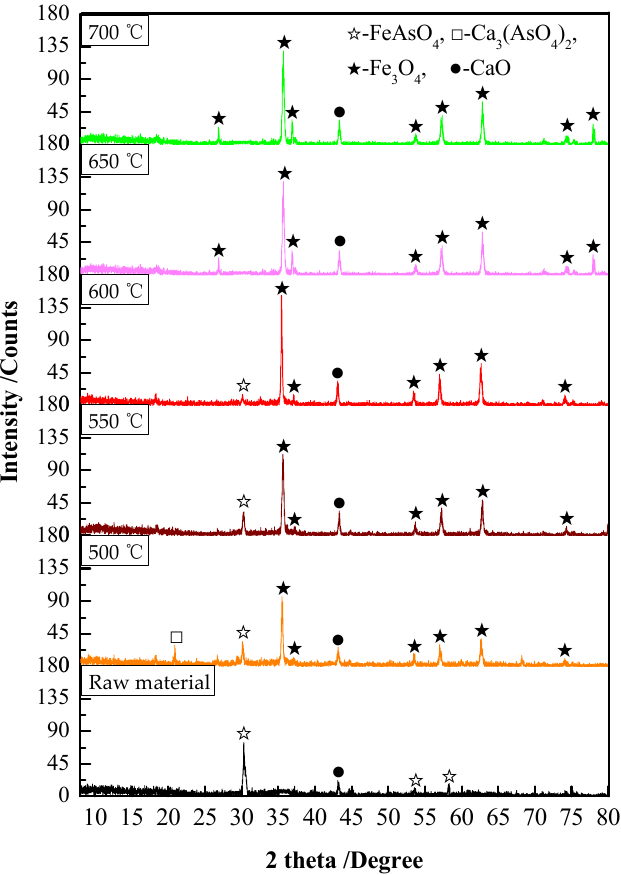
Figure 5. Influence of temperature on the experimental results.